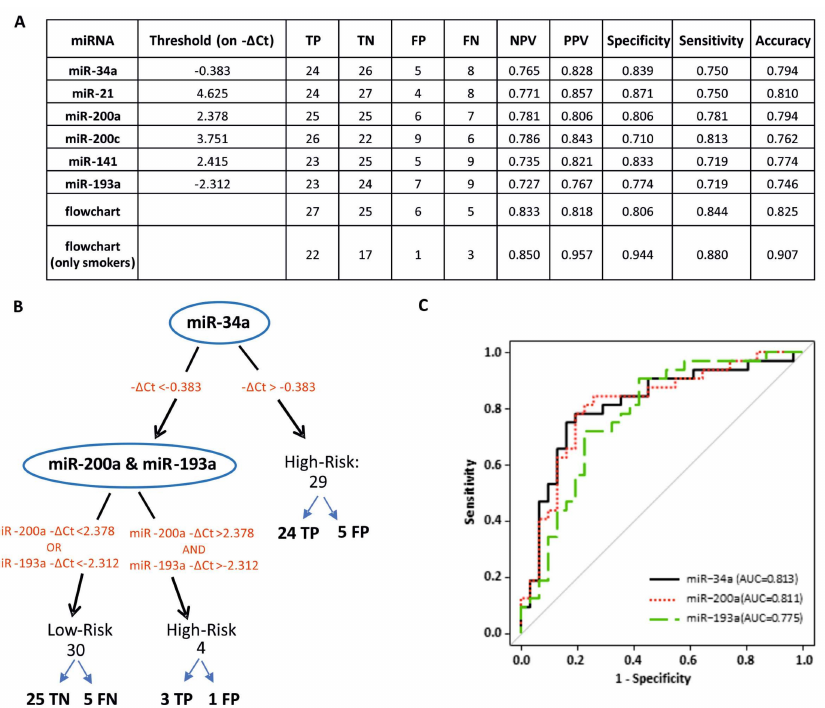
Figure 3. Urine cell-free miR-34a, miR-193a and miR-200a for BCa risk stratification. ( A ). Assessment of the performance of di ff erent patient stratification strategies. The table shows the thresholds and metrics for the evaluation of each biomarker’s performance in our data set. The miRNAs and the flowchart were evaluated for their ability to classify patients as high-risk or low-risk. Abbreviations: TP = true positive; TN = true negative; FP = false positive; FN = false negative; NPV = negative predictive value; PPV = positive predictive value. ( B ) Two-step decision flowchart for identification of high-risk BCa. A flowchart with miR-34, miR-193a and miR-200a as biomarkers and miR-125b as normalizer was designed to minimize the number of false negatives and improve the performance of individual miRNAs. The patients with − ∆ Ct miR-34a > − 0.383 are classified as high-risk. The remaining patients pass to the second step where they are evaluated for miR-200a and miR-193a; if the patient shows both − ∆ Ct miR-200a > 2.378 and − ∆ Ct miR-193a > − 2.312, he / she is classified as high-risk, if the patients show − ∆ Ct miR-200a < 2.378 and / or − ∆ Ct miR-193a < − 2.312 he / she is classified as low-risk. ( C ) Receiver operating characteristic (ROC) curve analysis. Shown are ROC curves and corresponding area under the curve (AUC) values for the cfmiRNAs employed in the